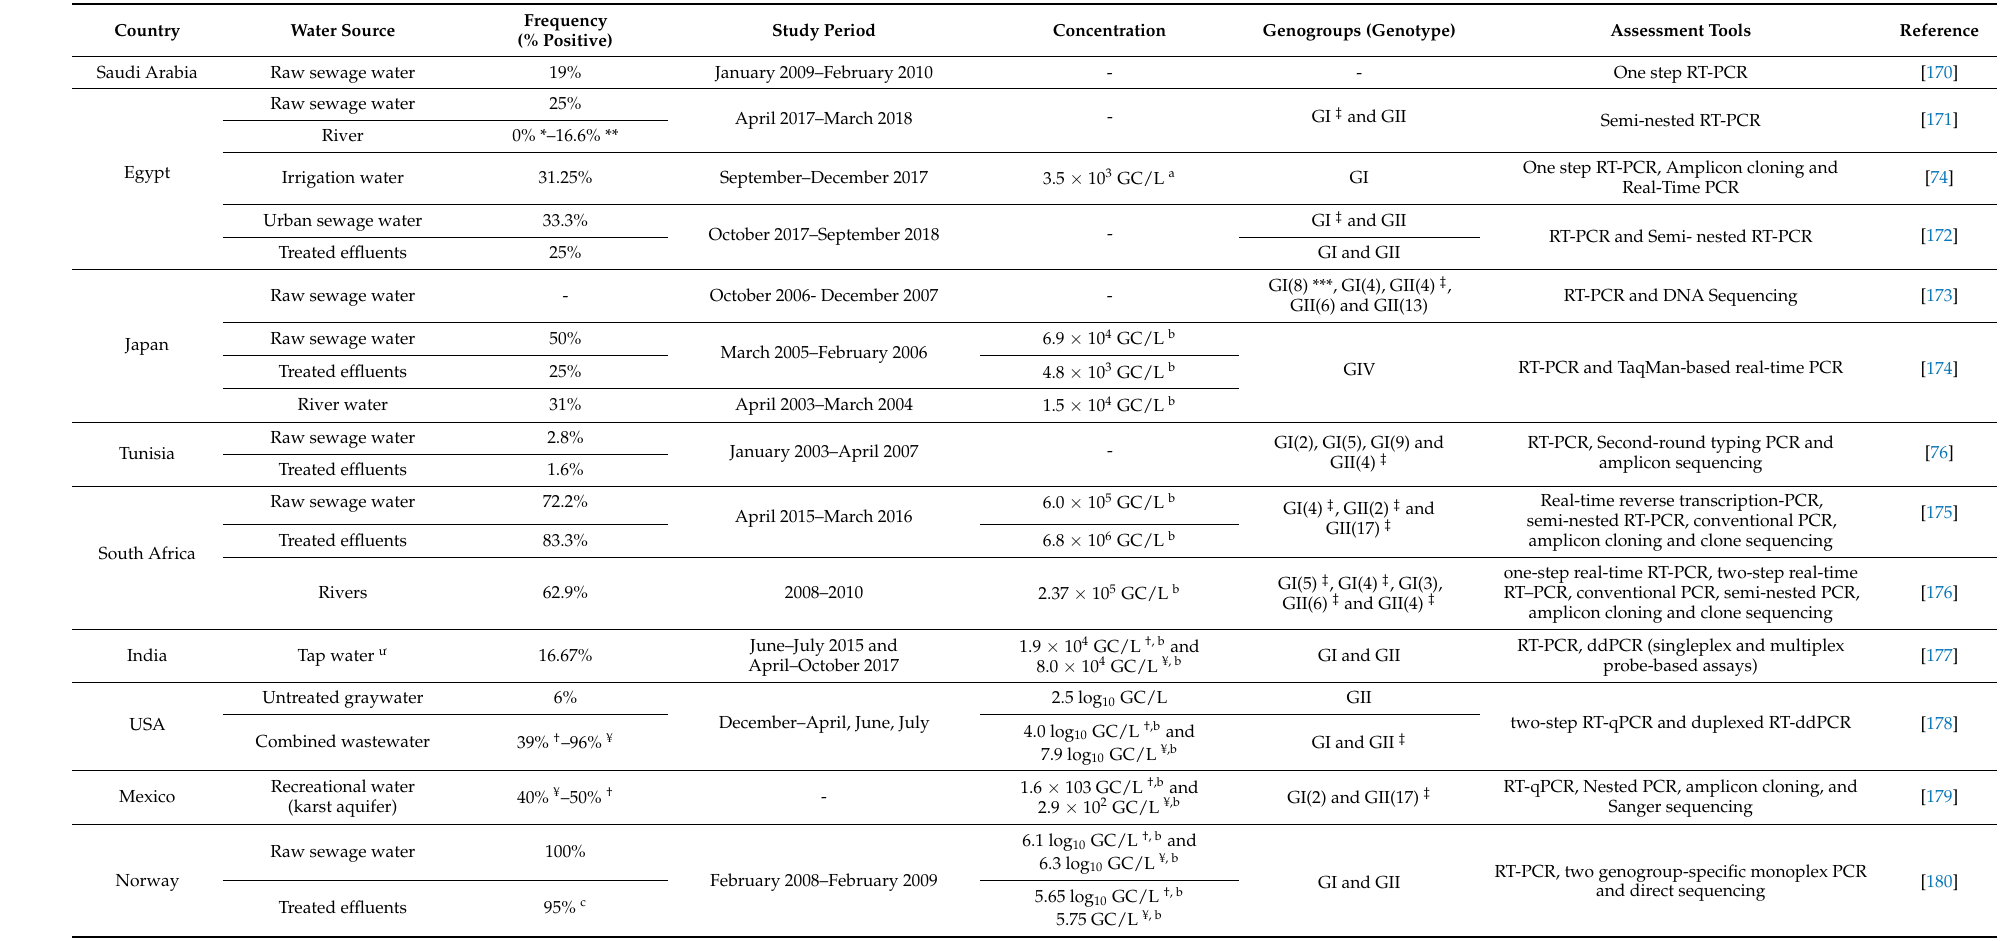
Table 3. Norovirus occurrence in various water